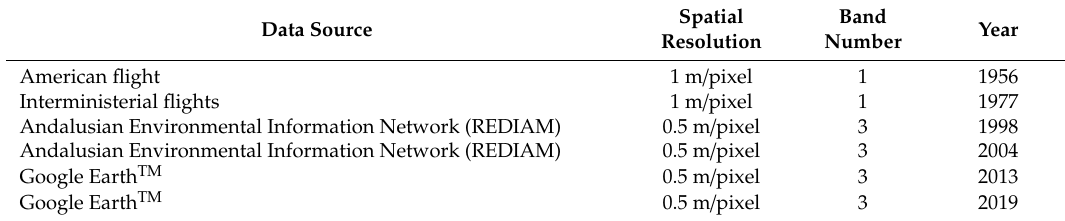
Data sources, spatial resolution, band numbers and year of the data used in the photointerpretation of olive tree